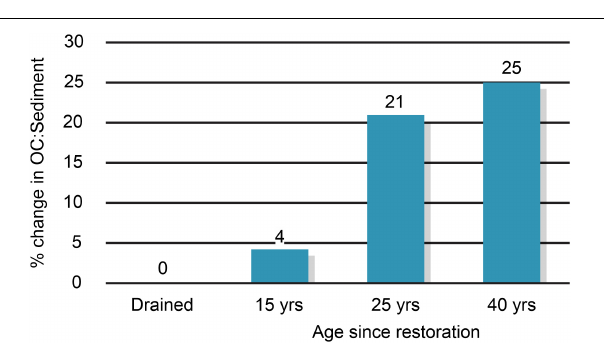
Frontiers in Ecology and Evolution |